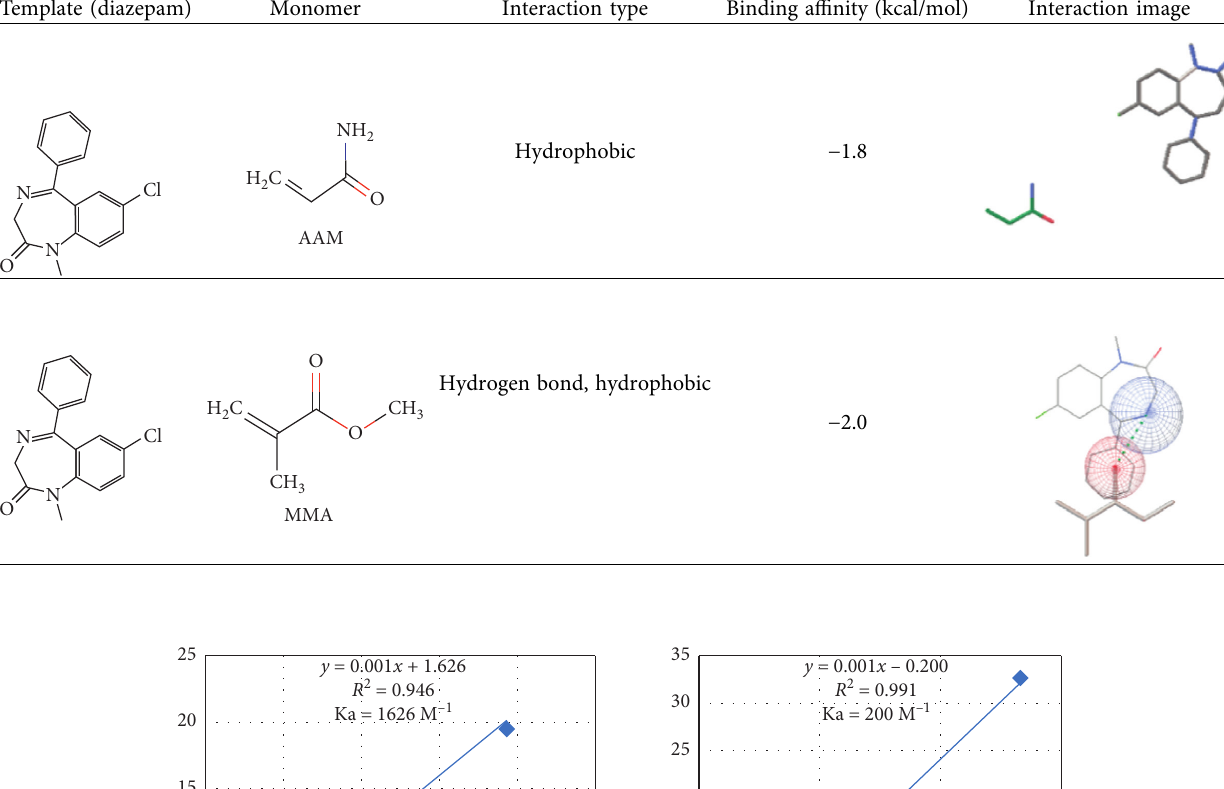
Table 1: Results from the computational approach used for the prediction of monomer-template interactions. Template